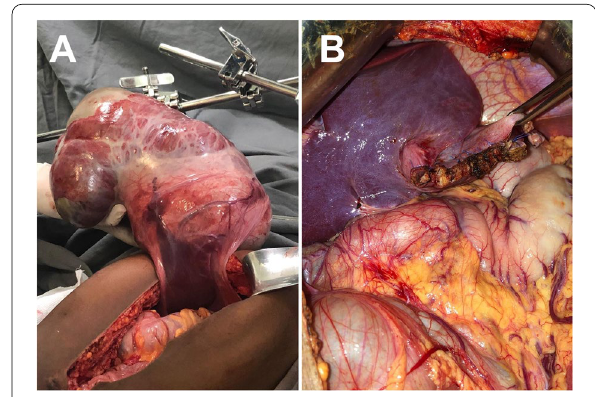
Fig. 2 Intraoperative images. A A pedicled cyst linked to the liver by a narrow bridge of hepatic tissue. B Final aspect of the left lobe of the liver (segments II and III) after complete excision of the